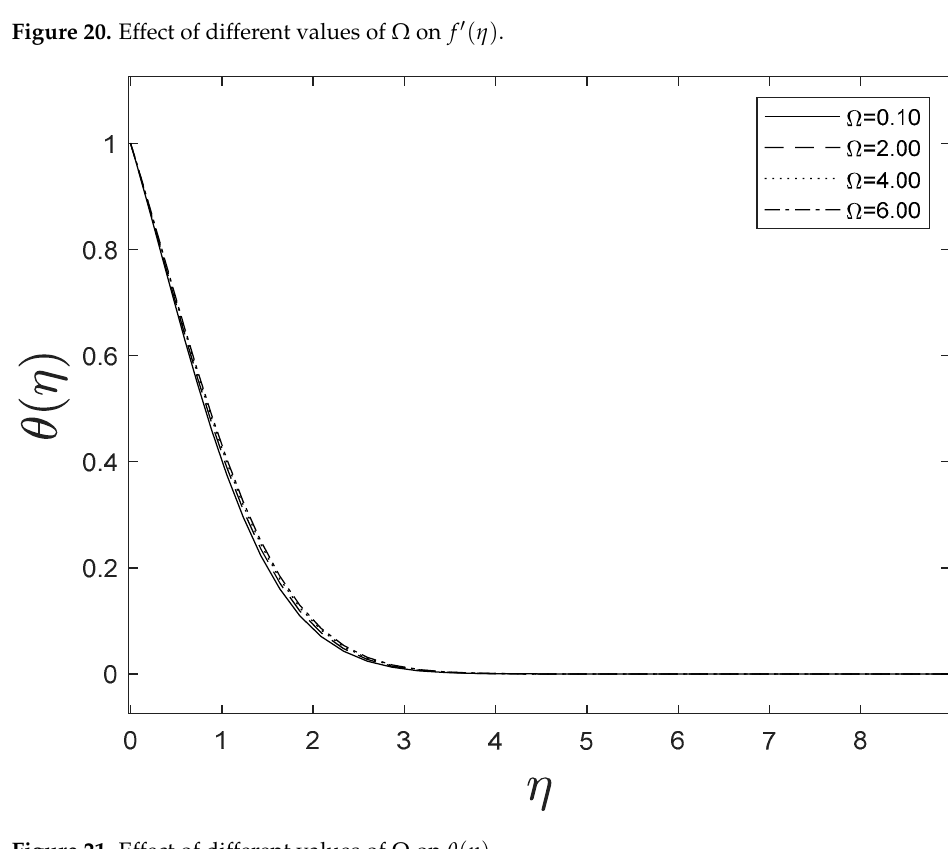
Figure 21. Effect of different values of